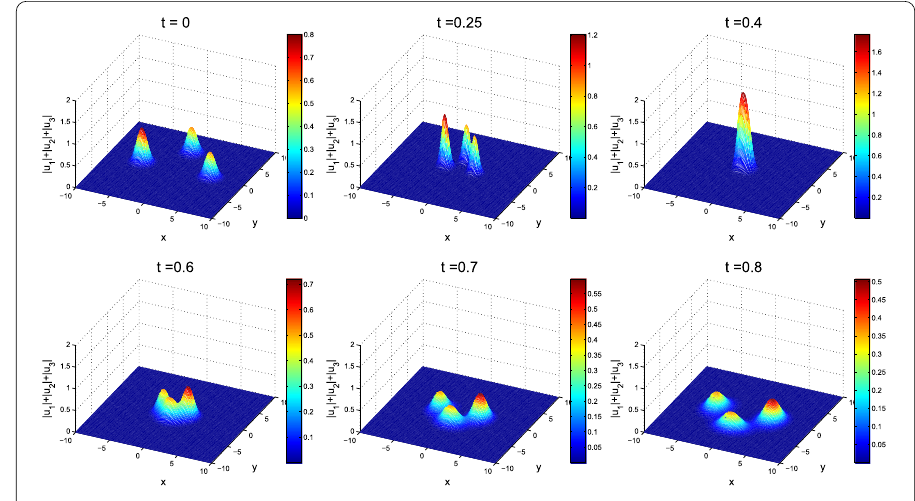
Figure 11 Surface plots of solutions to system (23) with (24) using the spectral ETDRK4-P22 scheme ( α = 1.8, N = 128 and τ = 0.001)